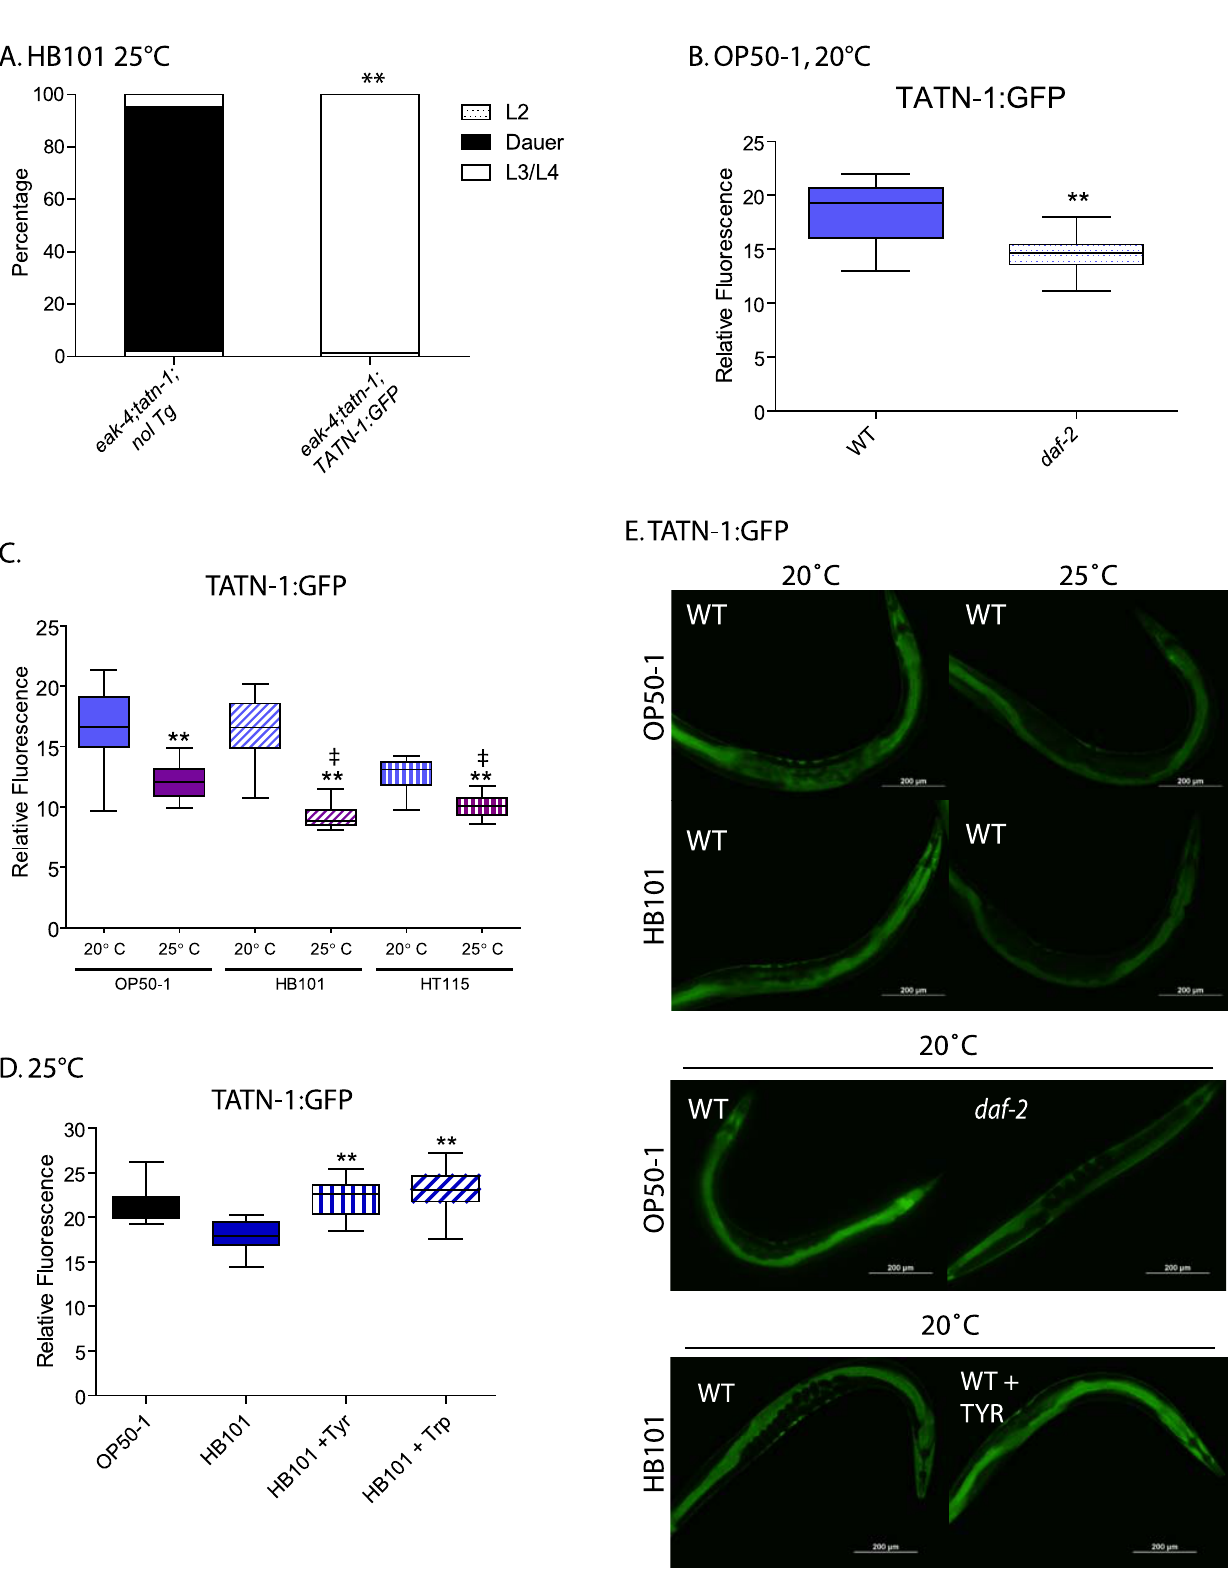
Figure 8. Control of TATN-1 protein expression by daf-2 /IGFR signaling, diet and temperature. (A) Rescue of tatn-1 mediated dauer arrest by a tatn-1p:tatn-1 cDNA:GFP transgene ( bafIs131) . (B) daf-2 signaling positively regulates TATN-1:GFP expression. Box and whiskers plot showing comparison of GFP fluorescence between day 1 adult wild-type and daf-2(e1368) mutants expressing the TATN-1:GFP transgene and grown on OP50- 1 bacteria. N $ 15 worms, ** p , 0.001 by t-test. (C) Bacterial food source and temperature regulate TATN-1:GFP expression. Wild-type worms expressing the TATN-1:GFP transgene were grown on the indicated bacteria until adulthood and then either kept at 20 u C or shifted to 25 u C overnight.